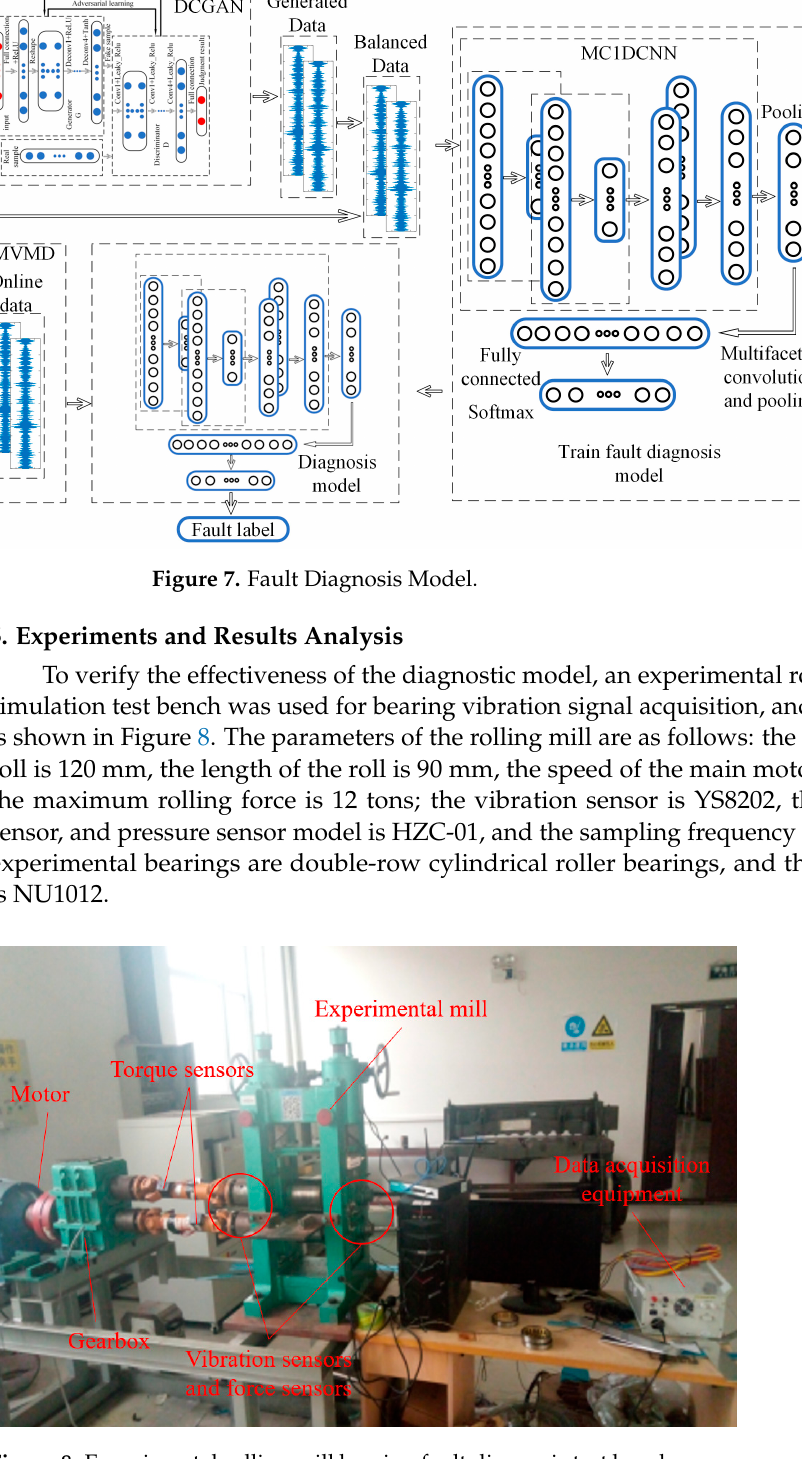
Figure 8. Experimental rolling mill bearing fault diagnosis test bench.